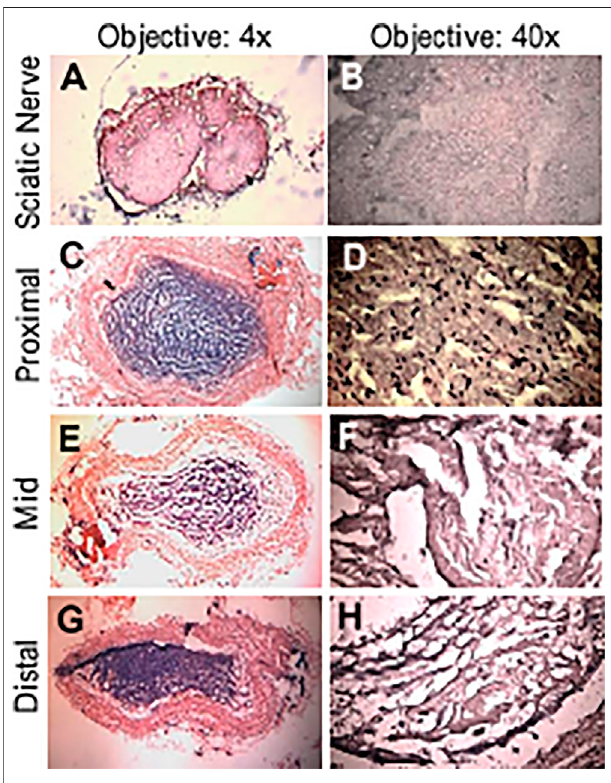
FIGURE6| HEofthesPVPnerveguidanceconduitinsciaticmodelofrats. (A) Sciatic nerve fi bers at low magni fi cation (objective: ×4). (C, E, and G) The proximal, middle, and distal regions of the sPVP nerve guidance conduit at low magni fi cation (objective: ×4), respectively. (B) Sciatic nerve fi bers at high magni fi cation (objective: ×40). (D, F, and H) The proximal, middle, and distal regions of the sPVP nerve guidance conduit at high magni fi cation (objective: ×40), respectively.